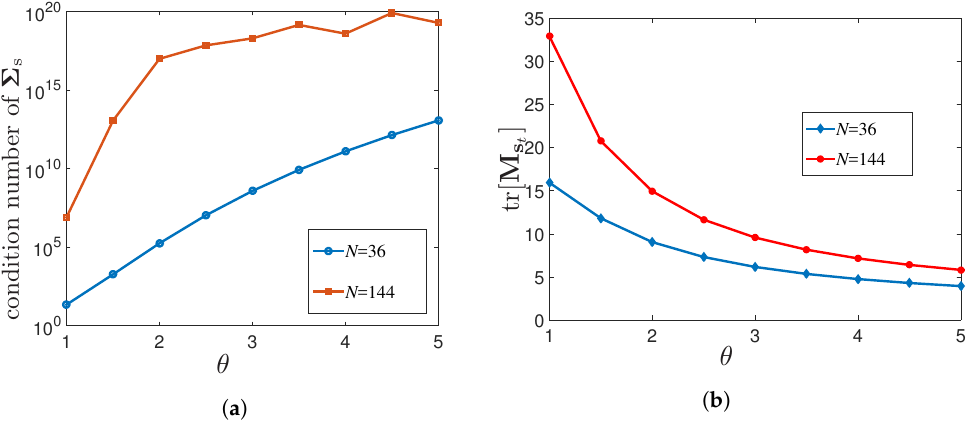
Figure 2. ( a ) Plot of the condition number of Σ s vs. θ with different number of candidate sensing locations ( N ); ( b ) MSE of the estimate of s t vs. θ for different numbers of candidate sensing locations ( N ); M t = N ; σ 2 e = 1; The spatial resolution is increased by representing one pixel of Figure 1a by 4